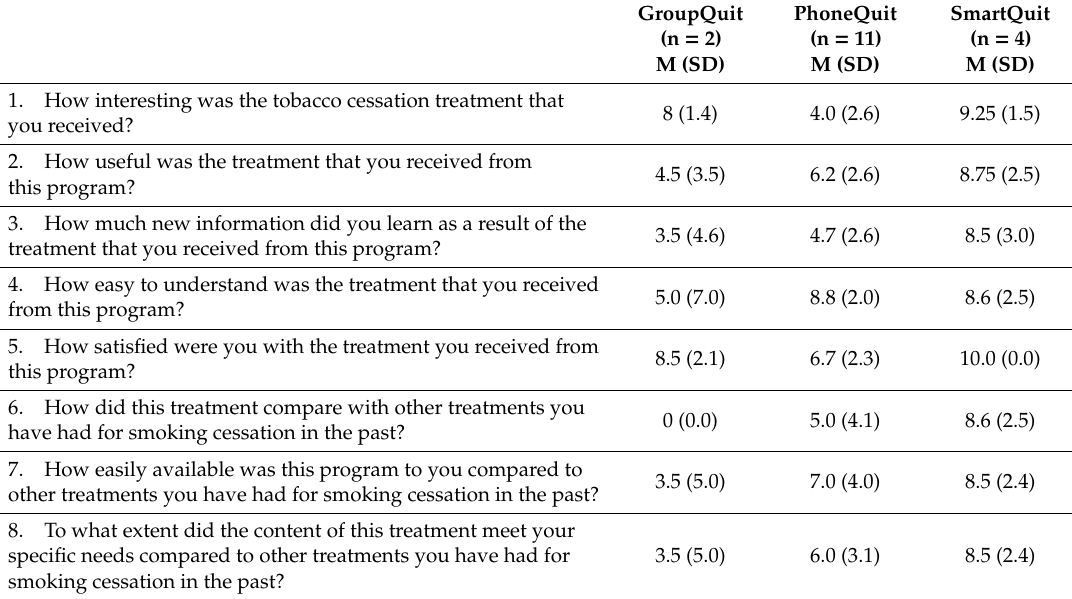
Table 5. Treatment Acceptability Questionnaire (n =